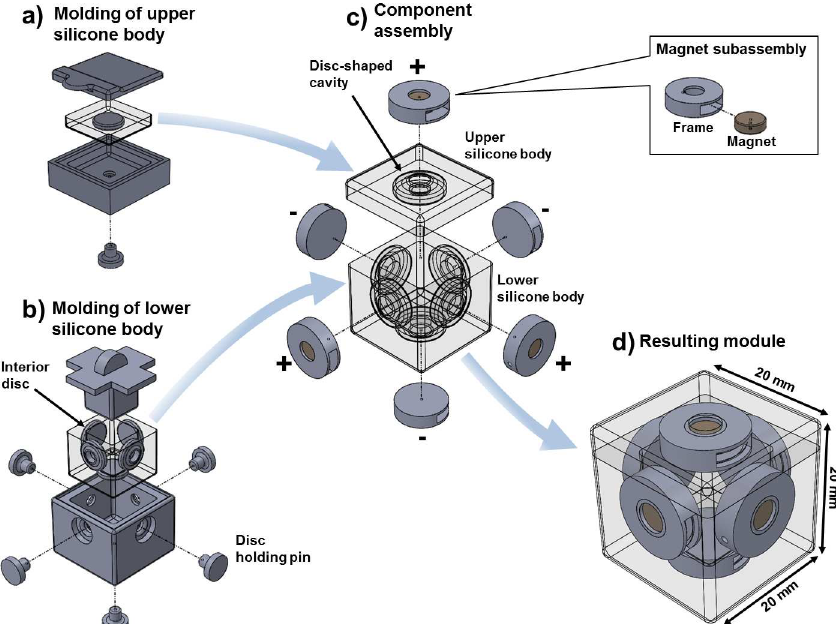
Fig 2. Fabrication of soft robotic modules. The process begins by producing two siliconebodiesusing multi-part 3D printed molds: the upper body (a) and the lower body (b). Removable pins hold the interior discs used to create cavities on each face. The resultingsiliconebodies are glued togetherand magnet subassemblies are introduced inside the resulting disc-shaped cavities (c). The insert shows how magnets are introduced inside a wrappingframe to enlargecontact surface with silicone and improvebonding.The resulting module is finally shown in